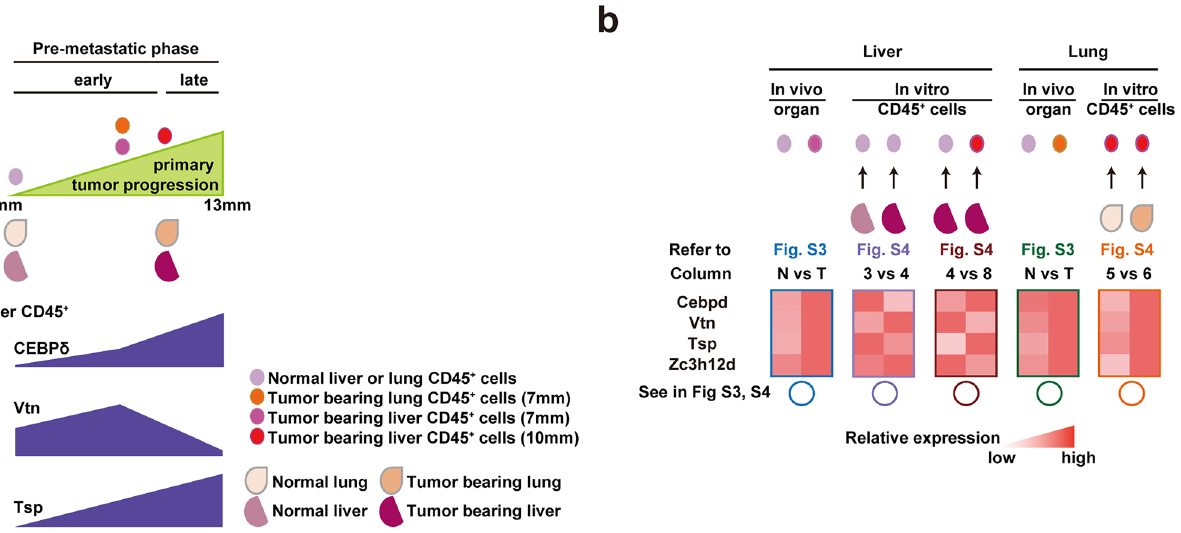
Figure 2. Expression pattern relationships among Vtn, Tsp, Zc3h12d, and CEBPδ in liver CD45 + cells. ( a ) Timeline of inverse correlation between Vtn and Tsp, regulated by CEBPδ in tumor-bearing organs. In the early pre-metastatic phase, the primary tumor moderately upregulates CEBPδ and Vtn in liver CD45 + cells. In the late pre-metastatic phase, the growing primary tumor suppressed Vtn by highly expressed CEBPδ. Detached liver CD45 + cells journey to the lungs, inducing Tsp upregulation. ( b ) Heatmaps of the positive correlation between CEBPδ and Vtn in early non-metastatic liver tissue from a tumor-bearing mouse, based on the in vivo data shown in Supplementary Fig. S3 (blue circles), in which mRNA levels of Vtn, Tsp, ZC3H12D, and multiple liver- related transcription factors in organs obtained from tumor-free or E0771-bearing (tumor size; 7 mm) Color coded illustrations depict CD45 + cells, lung, or liver tissues depicted in ( a ). Reverse expression of CEBPδ and Vtn in liver CD45 + cells activated by tumor-free or tumor-bearing liver tissue, based on the in vitro data shown in Supplementary Fig. S4 (3 vs 4, light purple circles) in which mRNA levels in CD45 + cells stimulated by organ tissues derived from tumor-free or E0771-bearing (tumor size; 10 mm). If tumor-bearing (10 mm) liver CD45 + cells were stimulated by tumor-bearing livers, the expression pattern of CEBPδ and Vtn was inverse (4 vs 8, red– purple in Supplementary Fig.